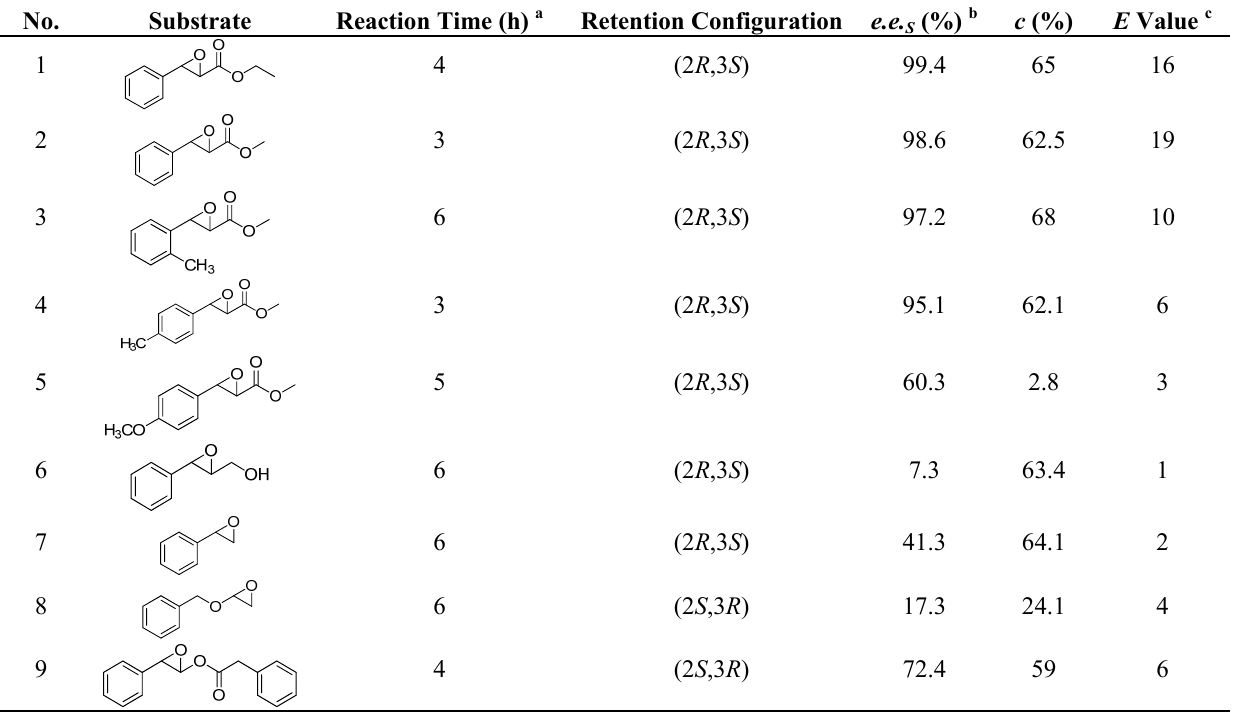
Table 1. Enantioselective hydrolysis of rac -EPG and its analogues by G. geotrichum ZJUTZQ200.